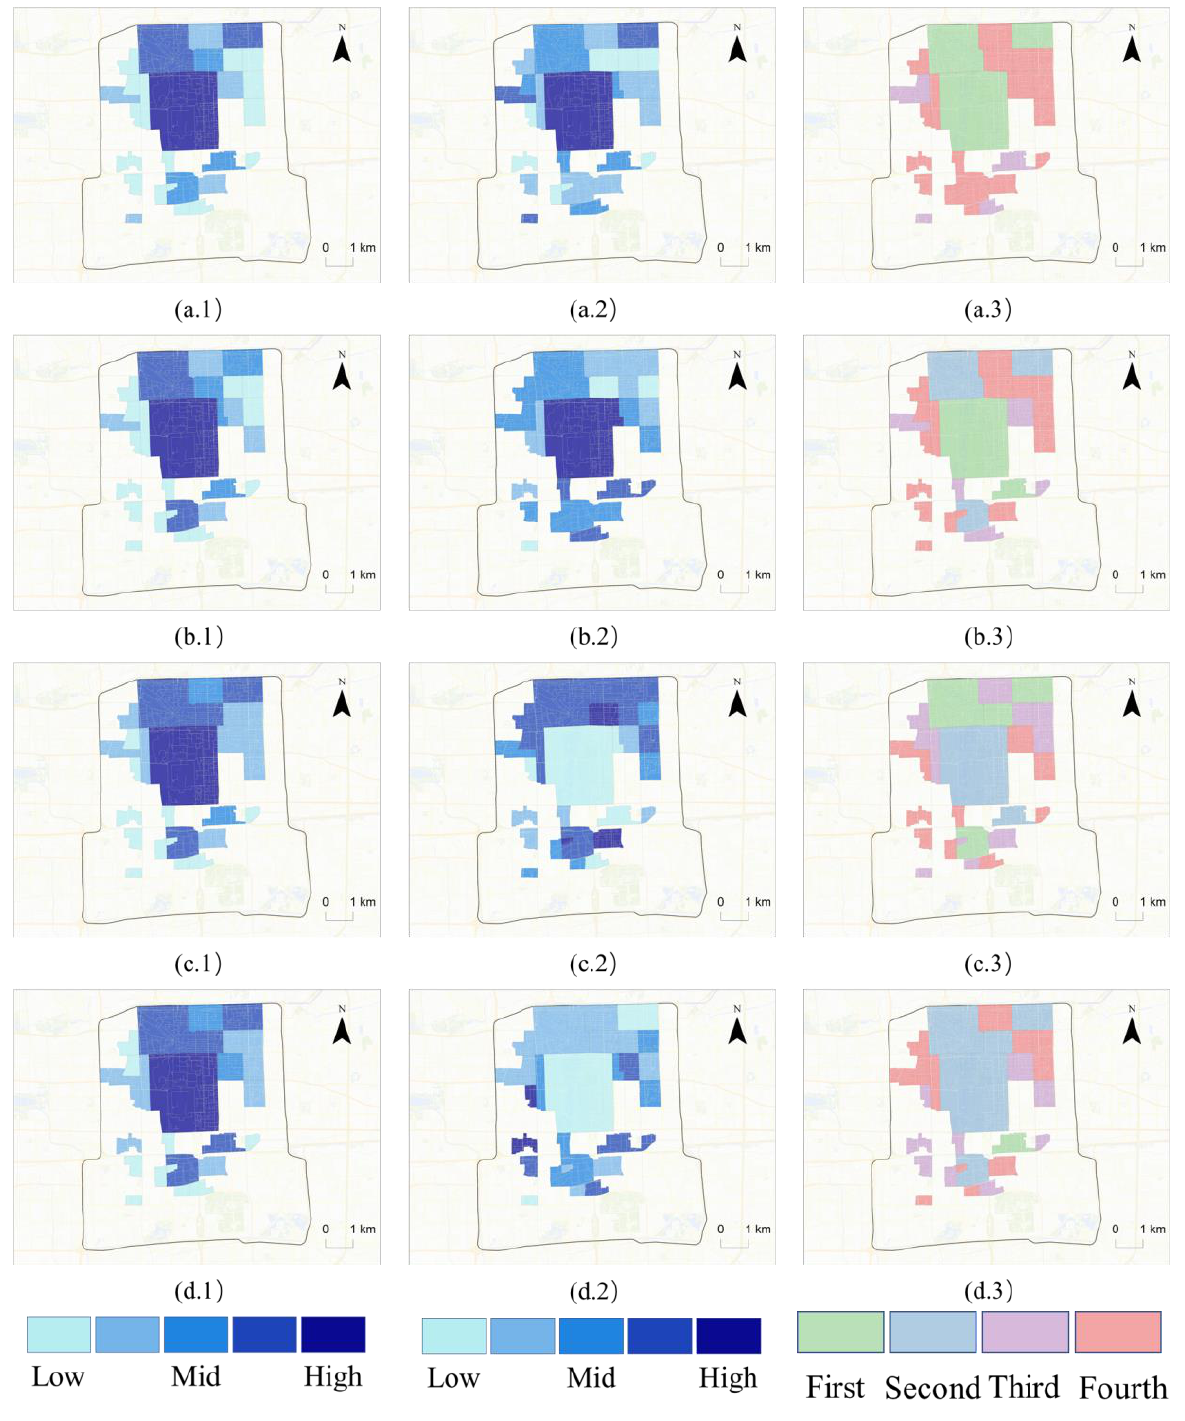
Figure 4. Distribution of absolute number, relative number, and four quadrants of various cultures in each block.